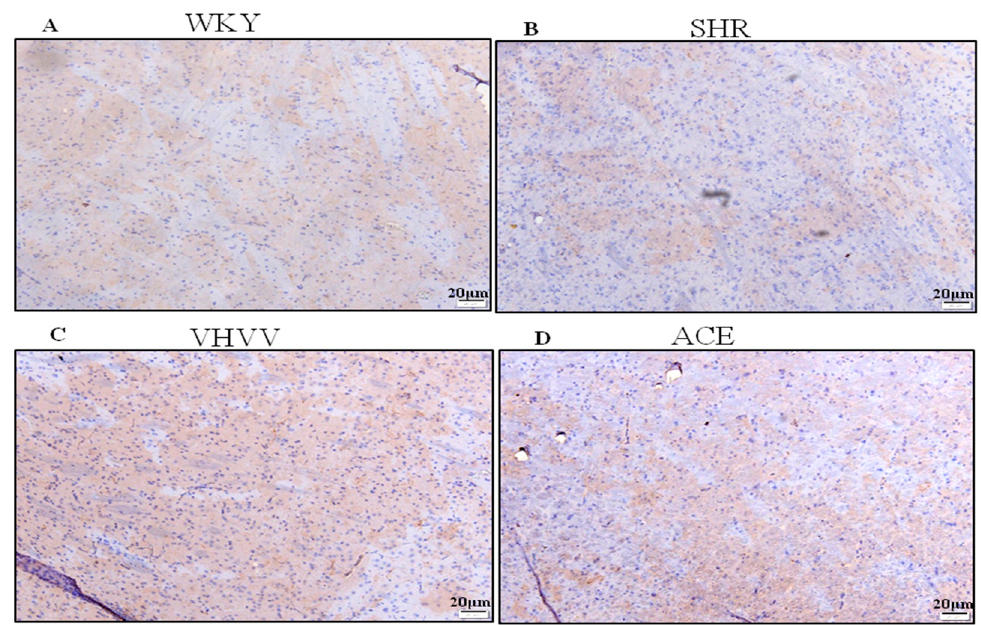
Figure 2. Immunohistochemistry (IHC) illustrating the expression level of brain-derived neurotrophic factor (BDNF) in the cortex. ( A ) The brown color indicated the expression and distribution of BDNF in tissue section. The scale bar is 20 µ m. The expression of BDNF in the control WKY group. ( B ) SHR rat brain cortex shows visibly decreased BDNF levels compared to the WKY, VHVV, and ACE groups. ( C ) VHVV-treated rats with visibly enhanced BDNF compared to all other groups. ( D ) ACE-treated rats show more enhanced BDNF levels than the SHR group but visibly decreased levels compared to VHVV.